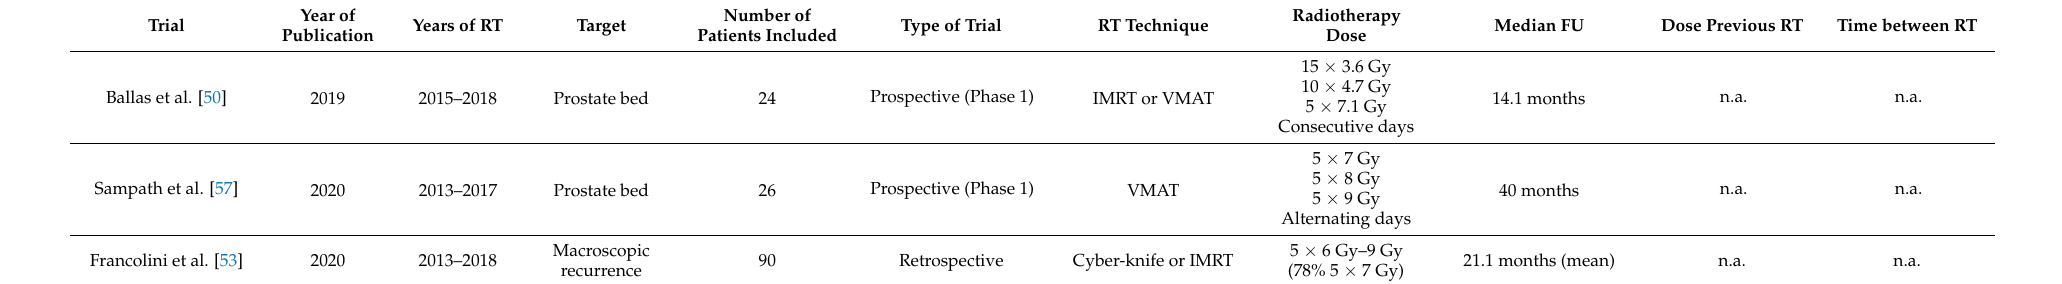
Table 1. Overview of trials including patients with salvage or adjuvant prostate bed SBRT without prior radiotherapy ( n = 3).